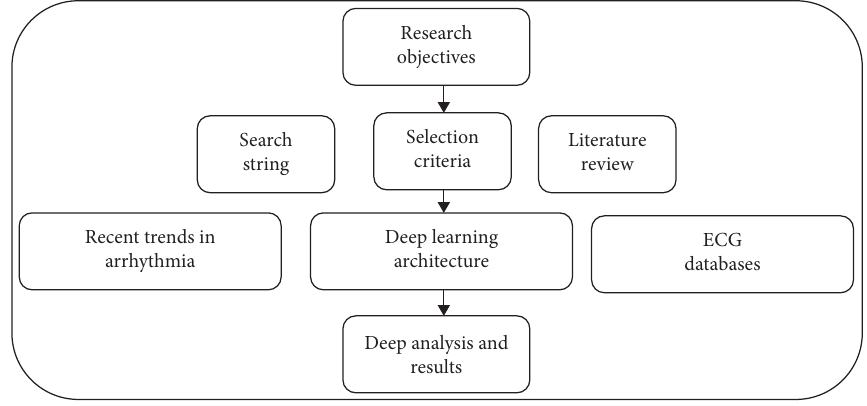
Figure 2: Systematic